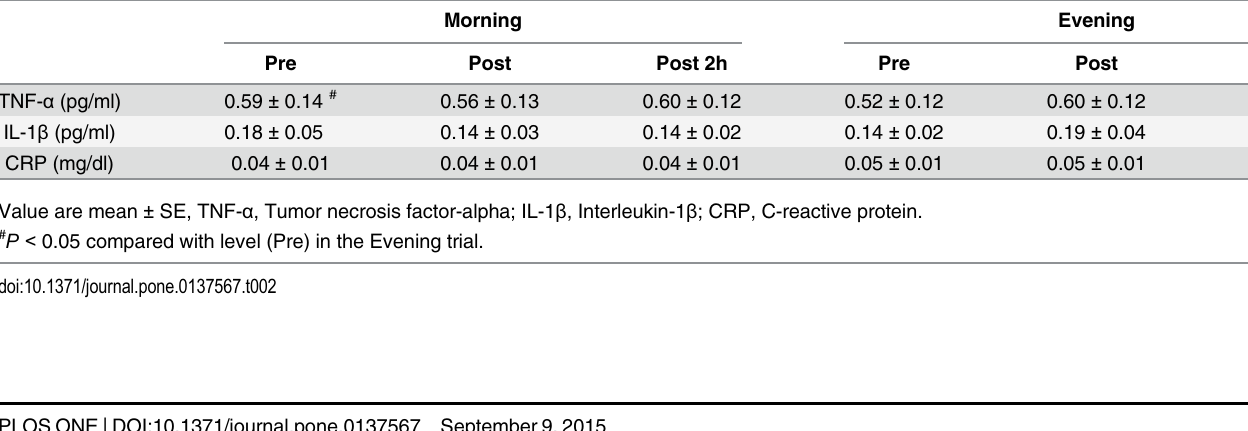
Table 2. Change in plasma cytokines and serum CRP in the morning and evening (N = 14). Morning Evening